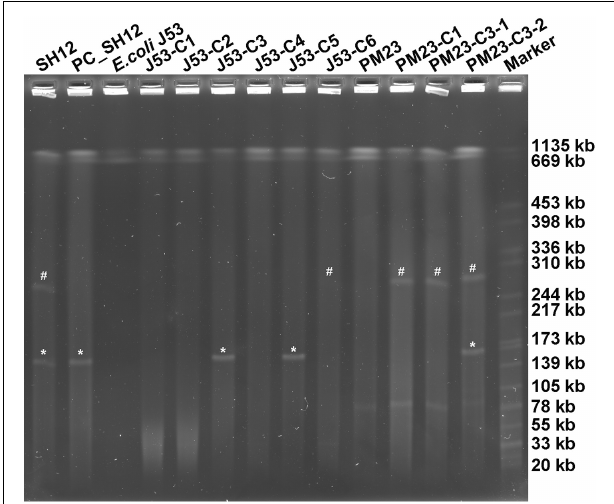
FIGURE 3 | S1-PFGE of strain SH12 and its transconjugants. Transconjugants J53-C1, J53-C2, J53-C4, and J53-C6 were found to receive virulence plasmid only; J53-C5 was found to receive the KPC plasmid only; J53-C3 was found to receive both plasmids. Transconjugant PM23-C1 was generated using J53-C1 as donor. Transconjugants PM23-C3-1 and PM23-C3-2 were generated using J53-C3 as donor. “#” denotes virulence plasmid pSH12_Vir, and “*” denotes KPC plasmid pSH12_KPC.